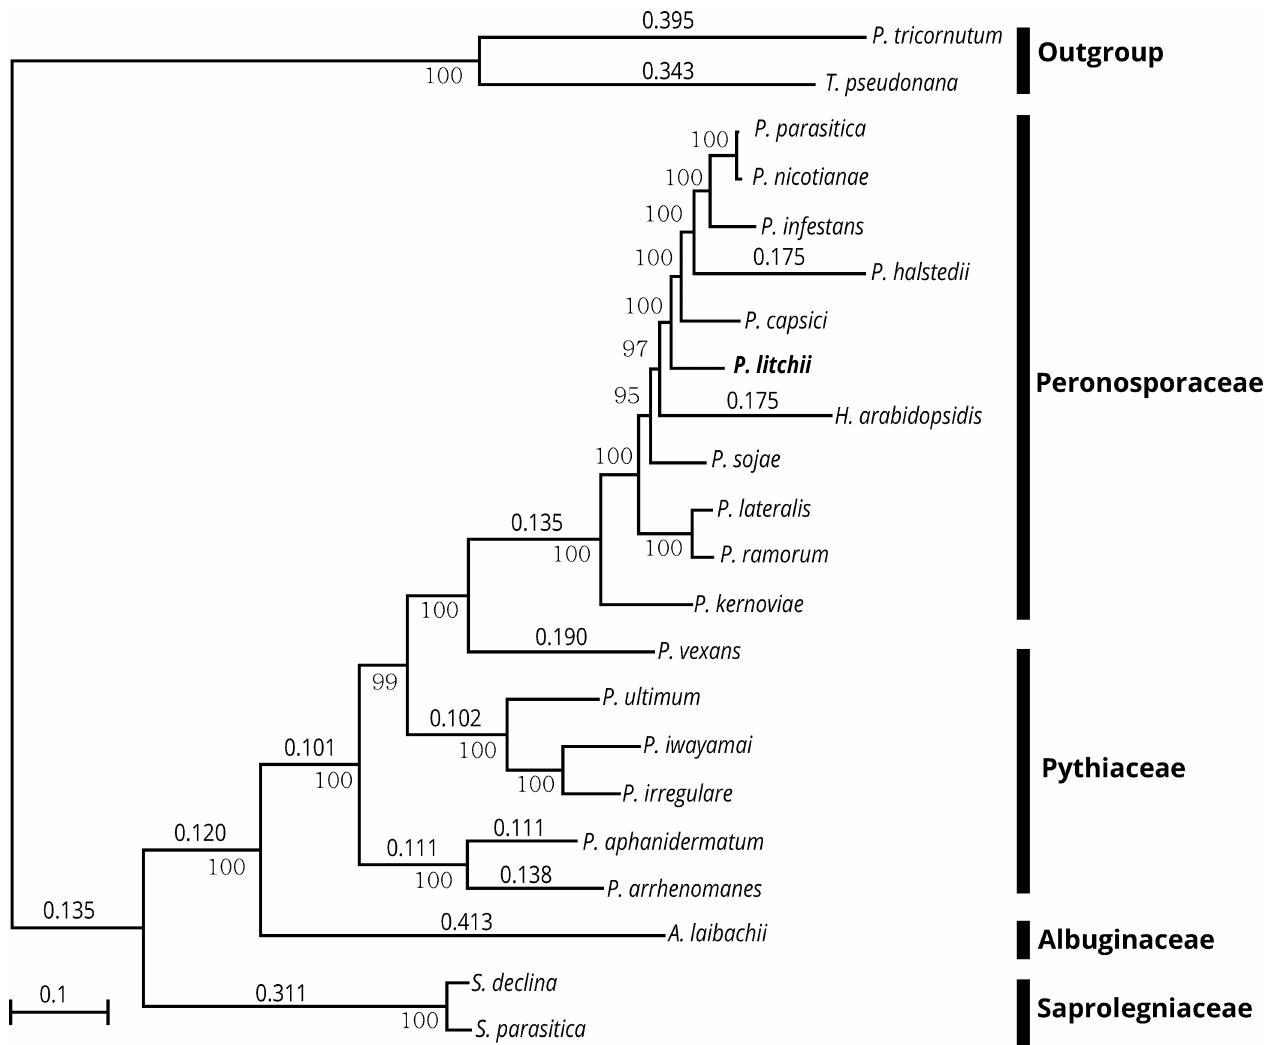
Fig 2. Phylogenetic tree of 22 oomycete species. Phylogenetic tree infered from the 164 single-copyproteins dataset by RAxML under the GAMMALGF model. ML bootstrapsupport (lower value)and genetic distance(upper value) were estimated under the uniform model.